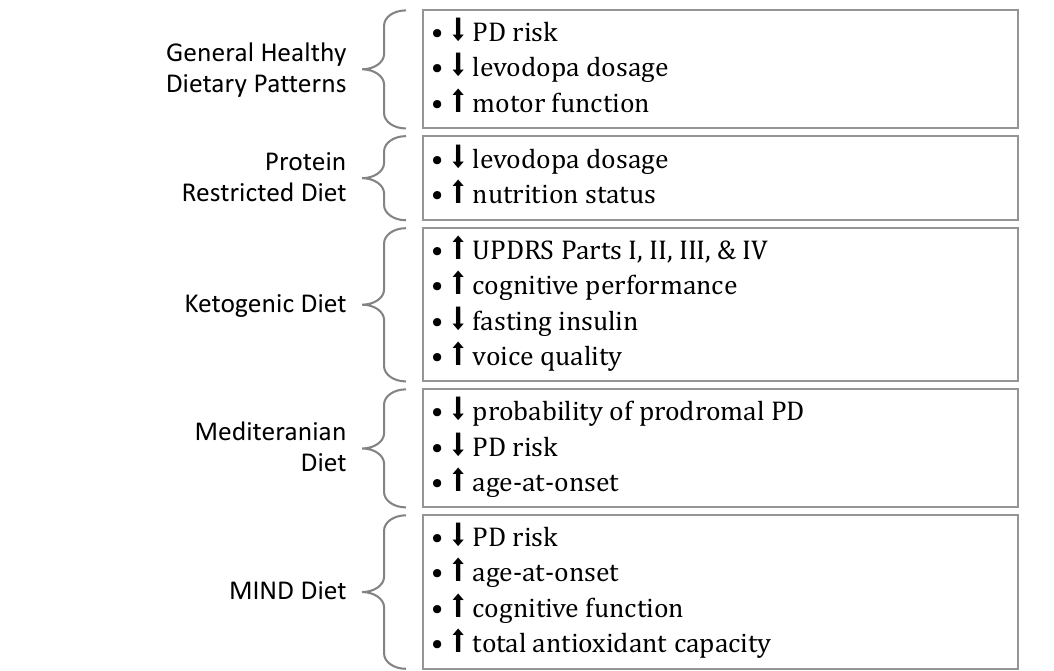
Figure 1. Potential benefits of different dietary patterns for individuals with PD. Upward arrows ( ↑ ) indicate the diet increased the following variable, while downward arrows ( ↓ ) indicate that the diet decreased the following variable .